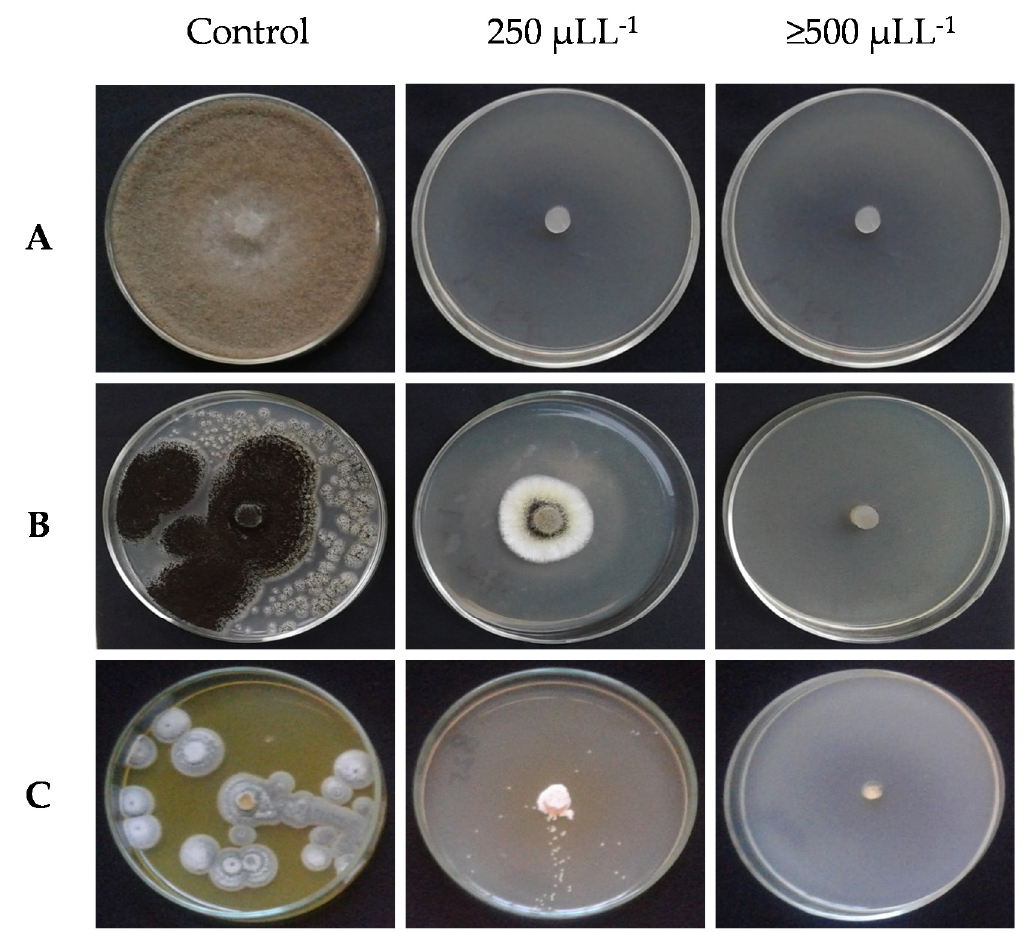
Figure 2. Antifungal activity of different concentration of T. kotschyanus EO on Botrytis cinerea ( A ), Penicillium expansum ( B ), and Aspergillus niger ( C ).